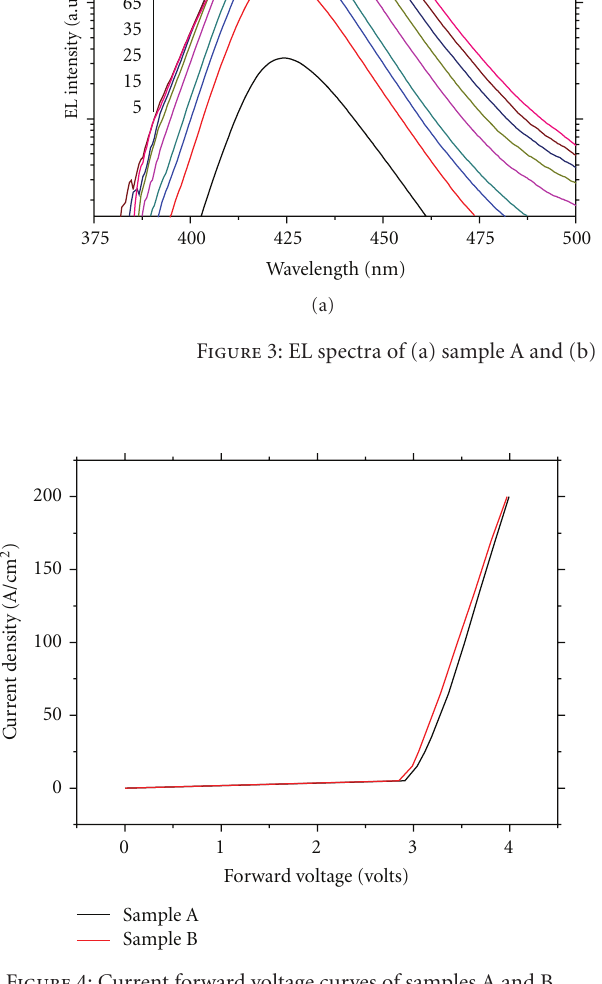
Figure 4: Current forward voltage curves of samples A and